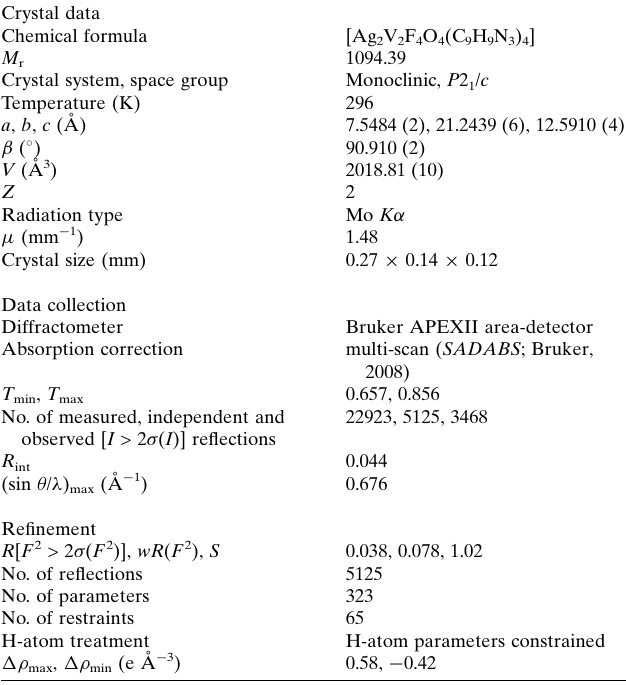
Crystal data Chemical formula